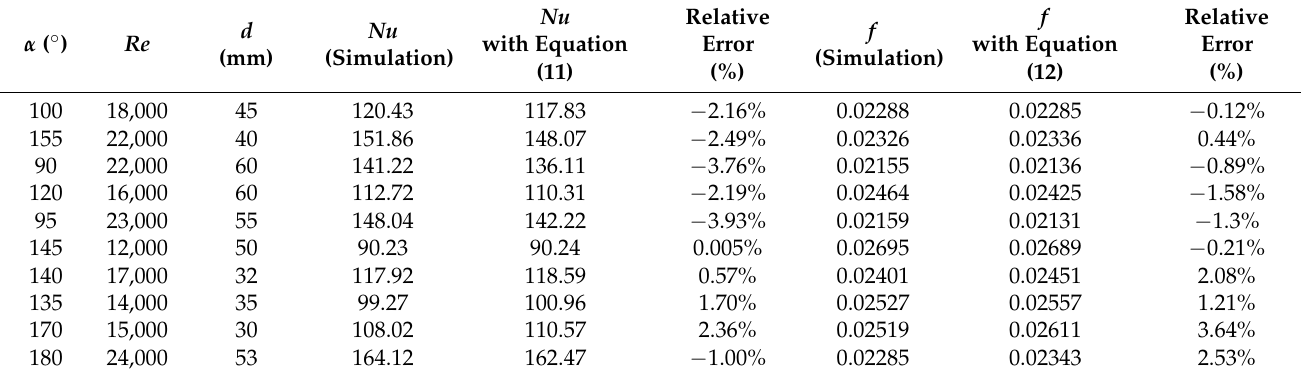
Table 4. Verification of the modified formula for straight